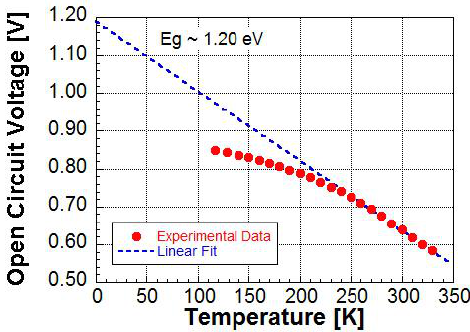
Figure 6. Temperature dependence of Voc of a typical CIGS solar cell fabricated by LTPED. The extrapolated value of Voc as T → 0 corresponds to Eg/q, where Eg is the absorber bandgap and q is the electron charge.